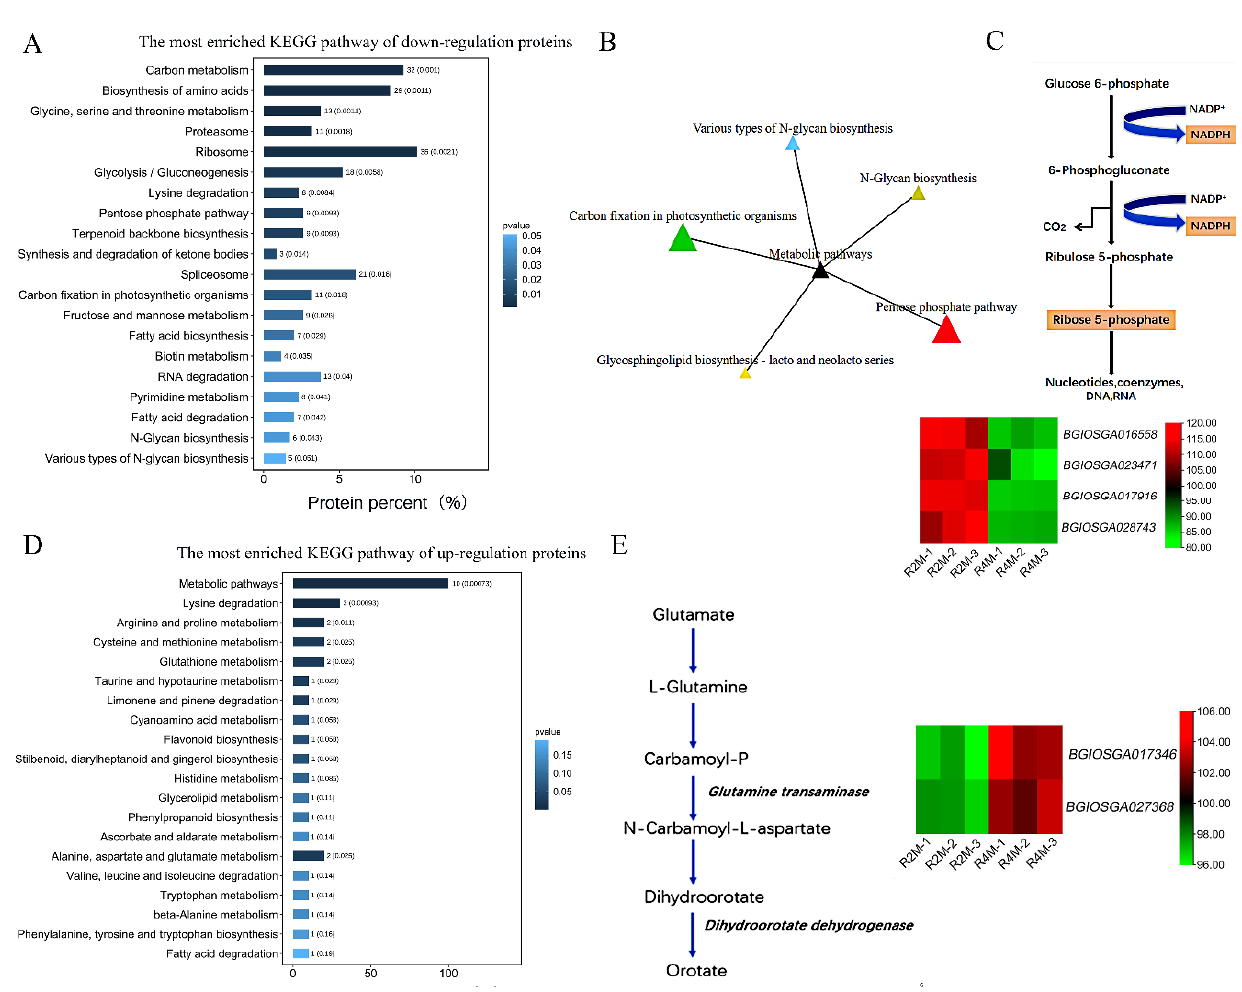
Figure 6. Correlation analysis of the pentose phosphate pathway (PPP) and glutamate decomposition. ( A ) KEGG (Kyoto Encyclopedia of Genes and Genomes) analysis of carbohydrate metabolism; ( B ) KEGG network diagram; ( C ) overview of the pentose phosphate pathway; ( D ) KEGG analysis of amino acid metabolism; ( E ) overview of glutamate decomposition.